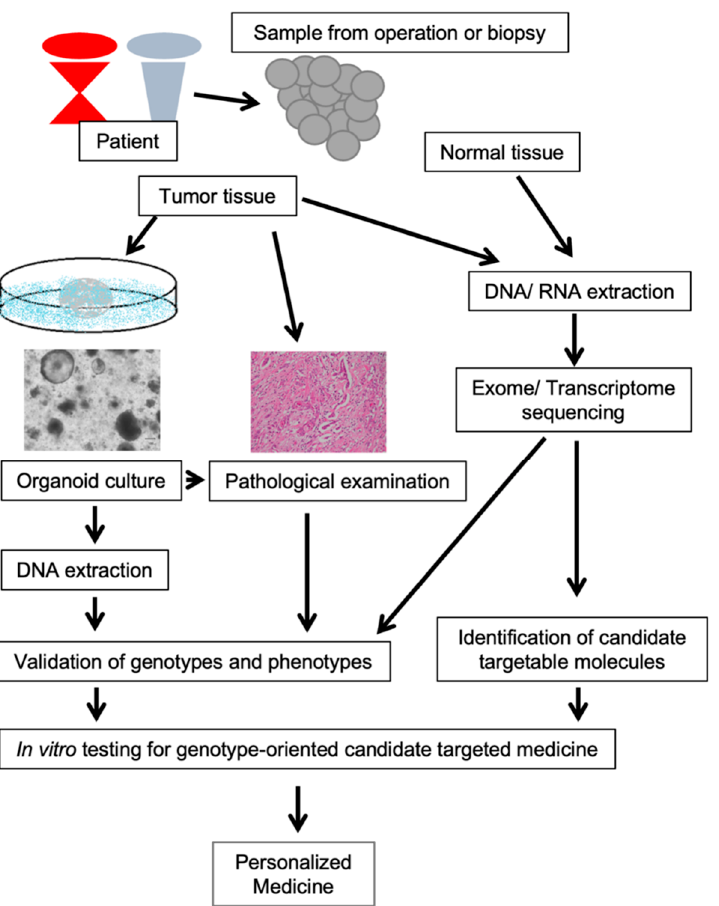
Figure 2. The genotype-oriented personalized medicine model we advocate combining comprehen- sive genotyping and organoid cultures. By combining exome sequencing and organoid culture, our model enabled the identification of genotype-oriented targets for personalized medicine and tested the efficacy of candidate targeted drugs in organoids.